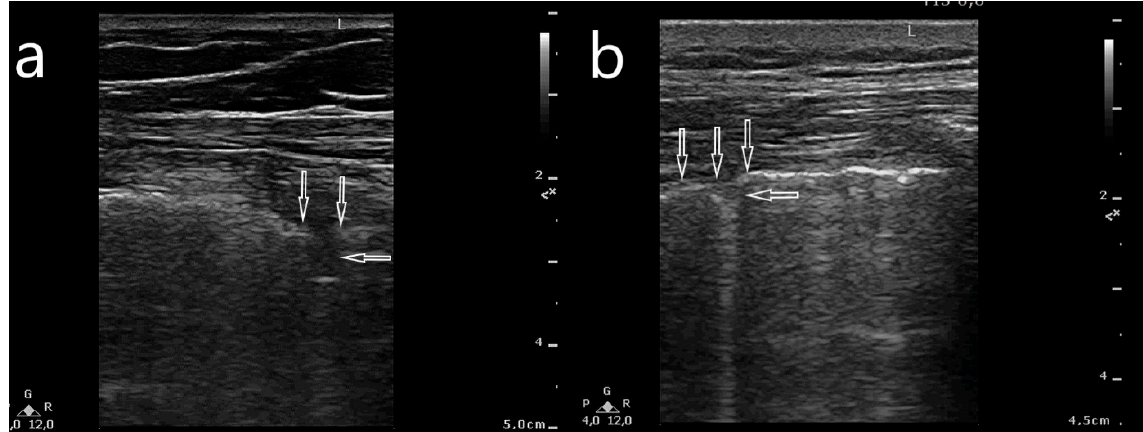
Figure 2. Abnormalities within the pleural line evaluated with a linear transducer: ( a ) fragmented pleural line corresponding to its segmental hypoechogenicity (between vertical arrows) and a small subpleural consolidation (horizontal arrow) (<5 mm); ( b ) irregular pleural line (vertical arrows), and a small subpleural consolidation (horizontal arrow).